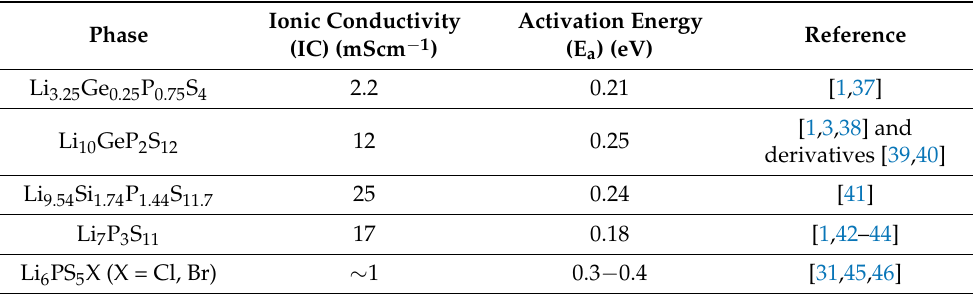
Table 1. Lithium superionic conductor phase